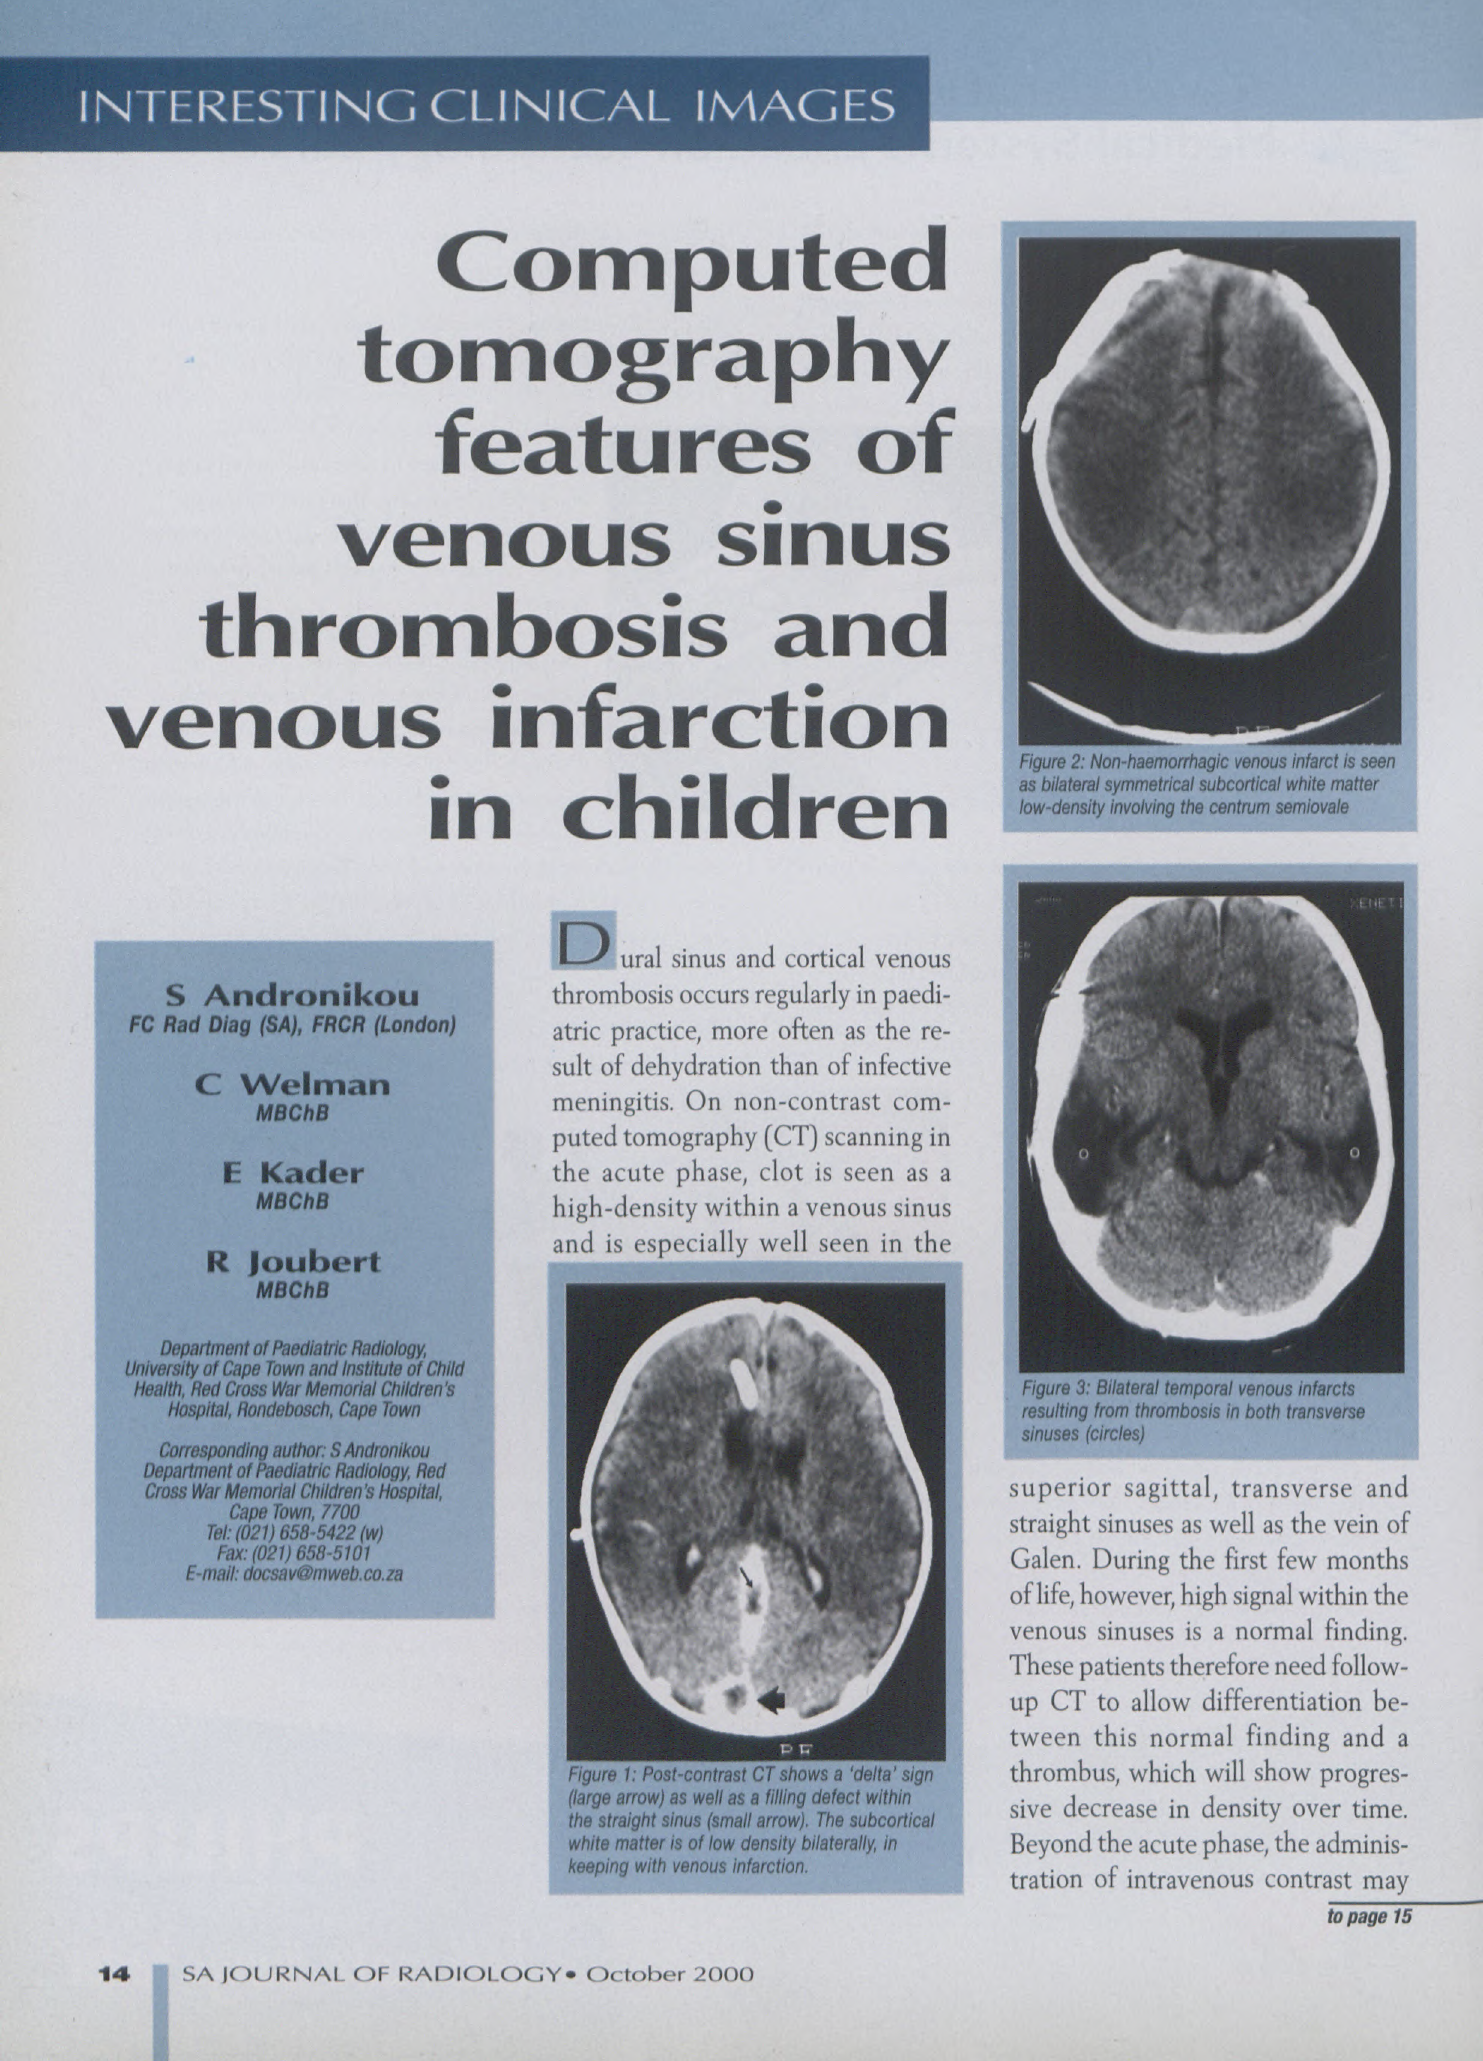
Figure 1: Post-contrast shows a 'delta' sign (/arge arrow) as well as a fill/ng defect within the straight sinus (small arrow). The subcortical white matter is of low density bilaterally, In keeping with venous Infarction.